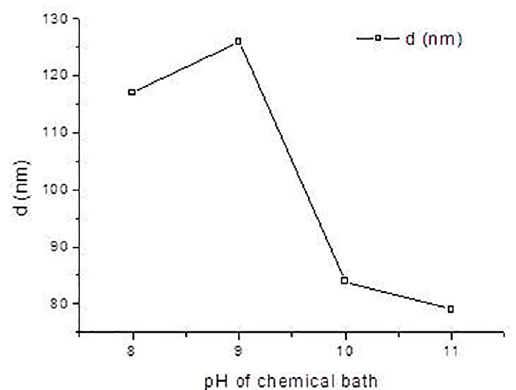
Figure 3. Plot of the film thickness (d) vs. different pHs.